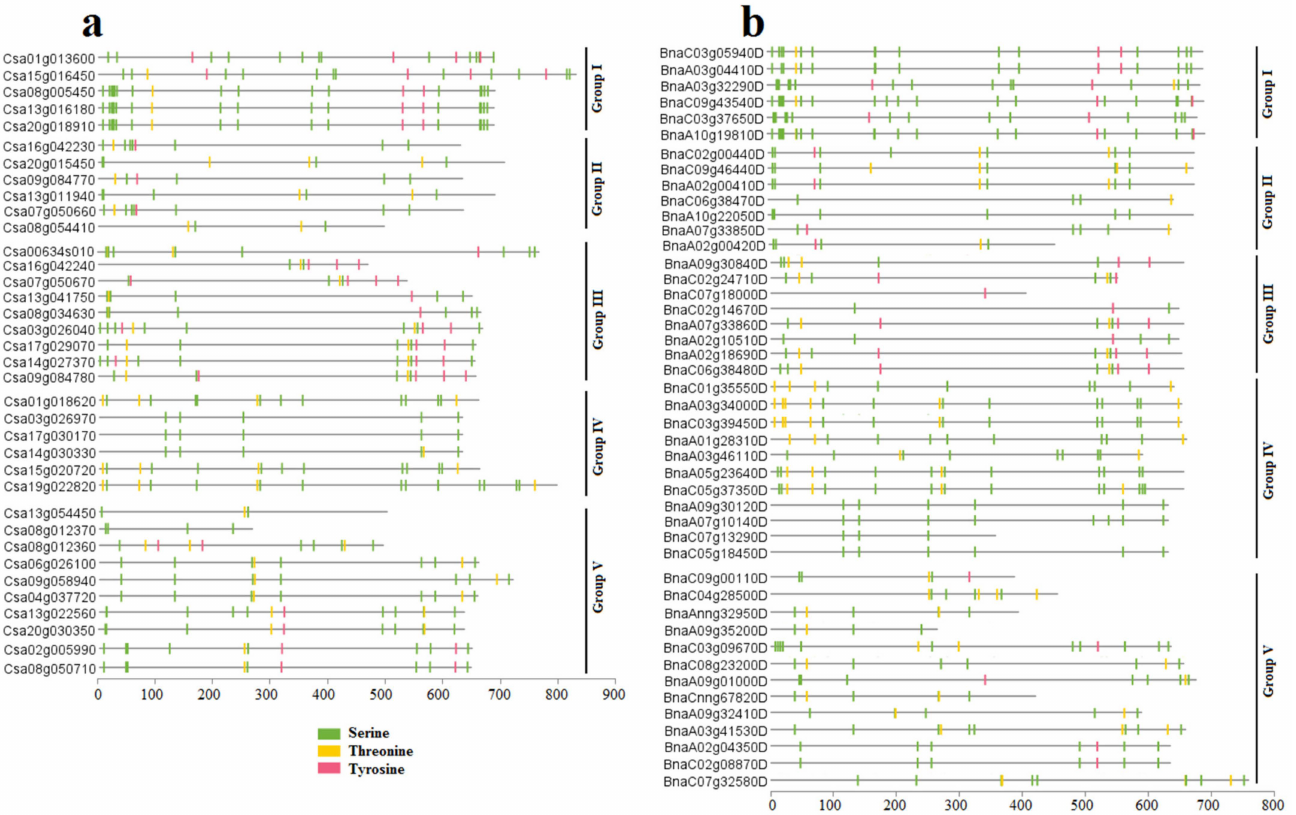
Figure 9. The prediction of phosphorylation sites in the SULTRs with scores ≥ 0.90 using the NetPhos 3.1 server: ( a ) C. sativa ; ( b ) B. napus . The grouping was based on the phylogenetic